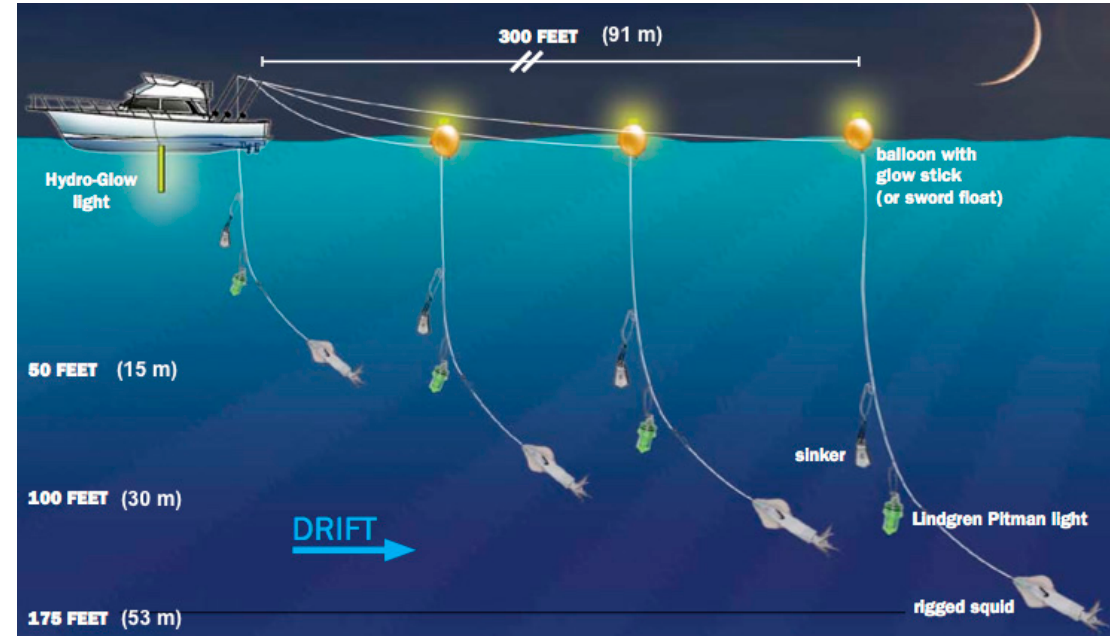
Figure 3. Typical recreational swordfish nighttime fishing setup. Diagram by Jon Pilcher, MD [14].